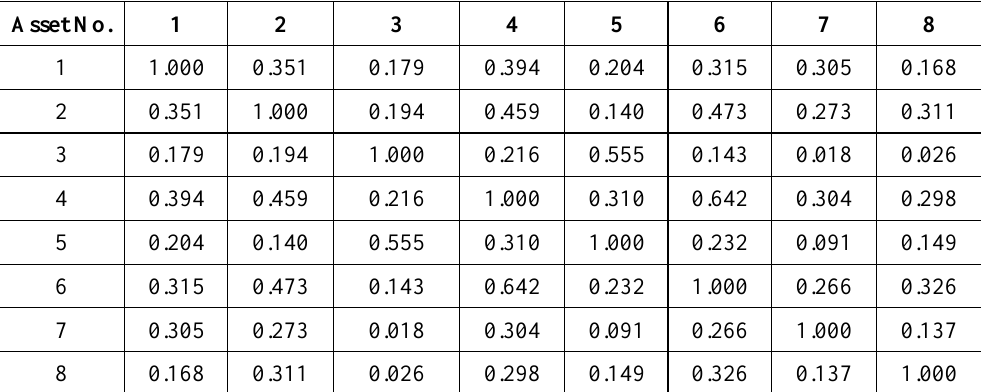
Table 4. The third scenario for the correlation coefficient matrix Asset No.